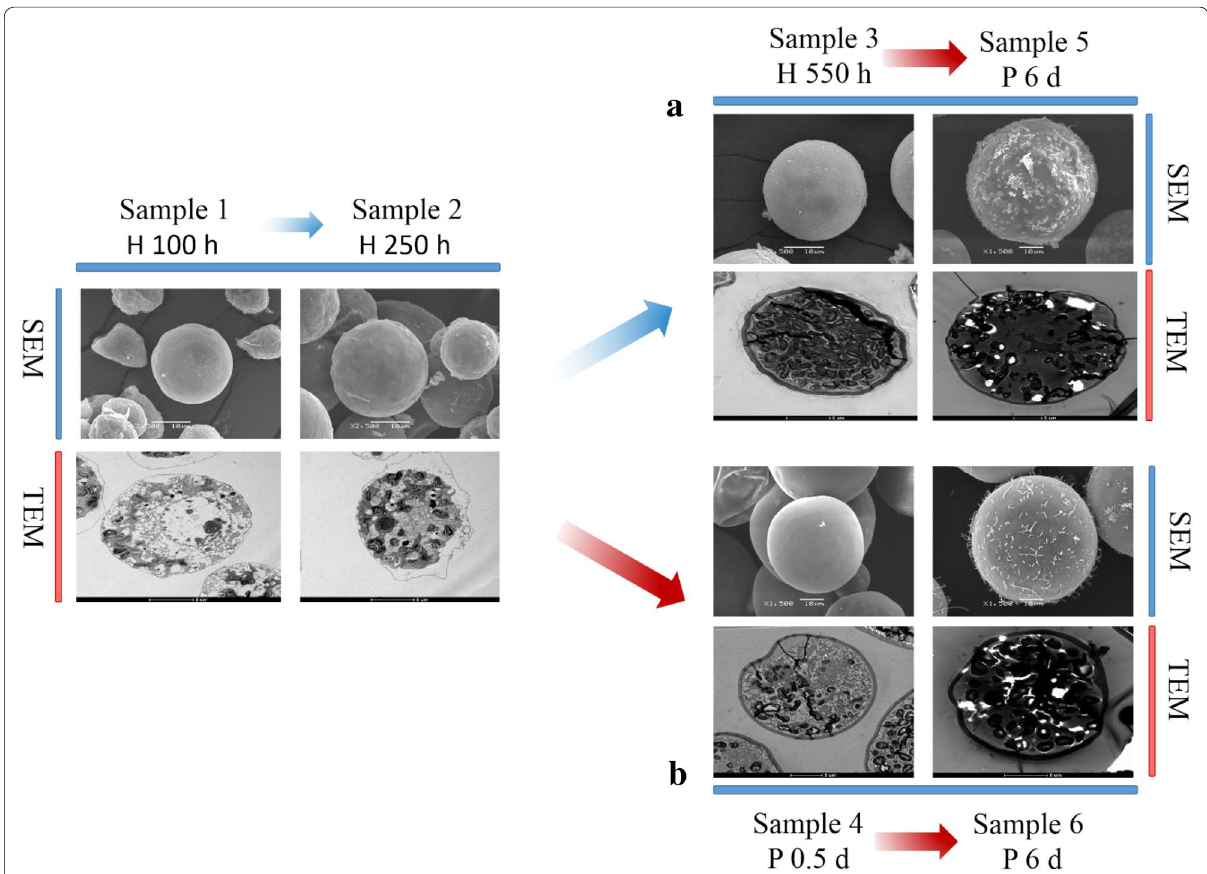
Fig. 1 Images of H . pluvialis cells at different time points. H . pluvialis images of control group ( a 1235 SHDP route) and treatment group ( b 1246 SHDP route) were conducted using scanning electron microscope (SEM, scale bar 10 μm) and transmission electron microscope (TEM, scale = bar 5 μm), respectively. In both routes, samples 1 and 2 were the same heterotrophic sample at 100 h and 250 h, respectively. H 100 h, H 250 h = and H 550 h represent heterotrophic culture for 100 h, 250 h and 550 h, respectively. P 0.5 days and P 6 days represent photoinduction for 0.5 days and 6 days, respectively. Blue arrow and red arrow represent heterotrophic culture and photoinduction,